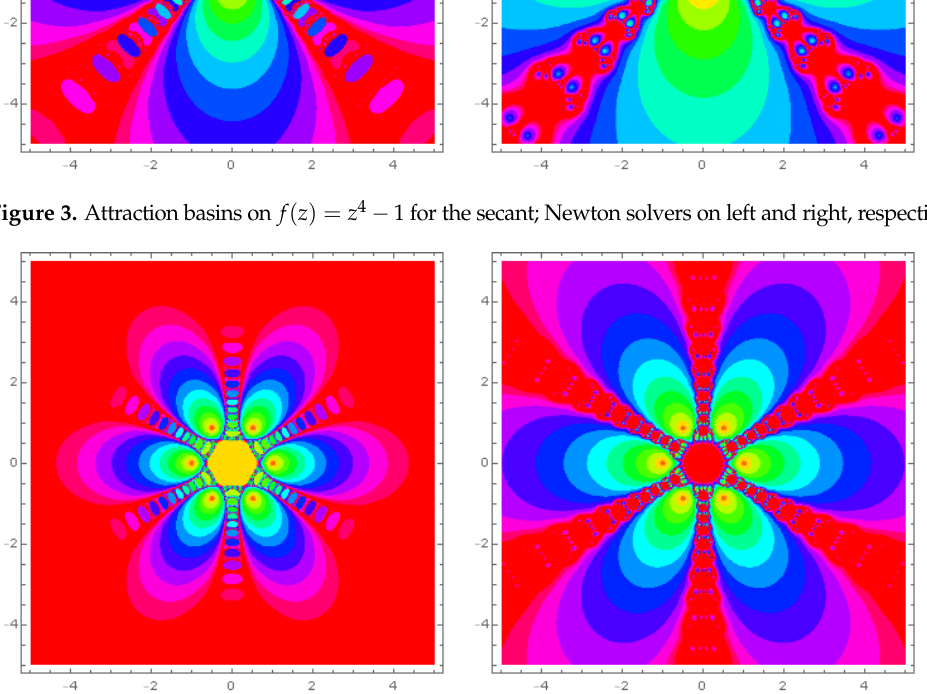
Figure 4. Attraction basins on f ( z ) = z 6 − 1 for the secant; Newton solvers on left and right,